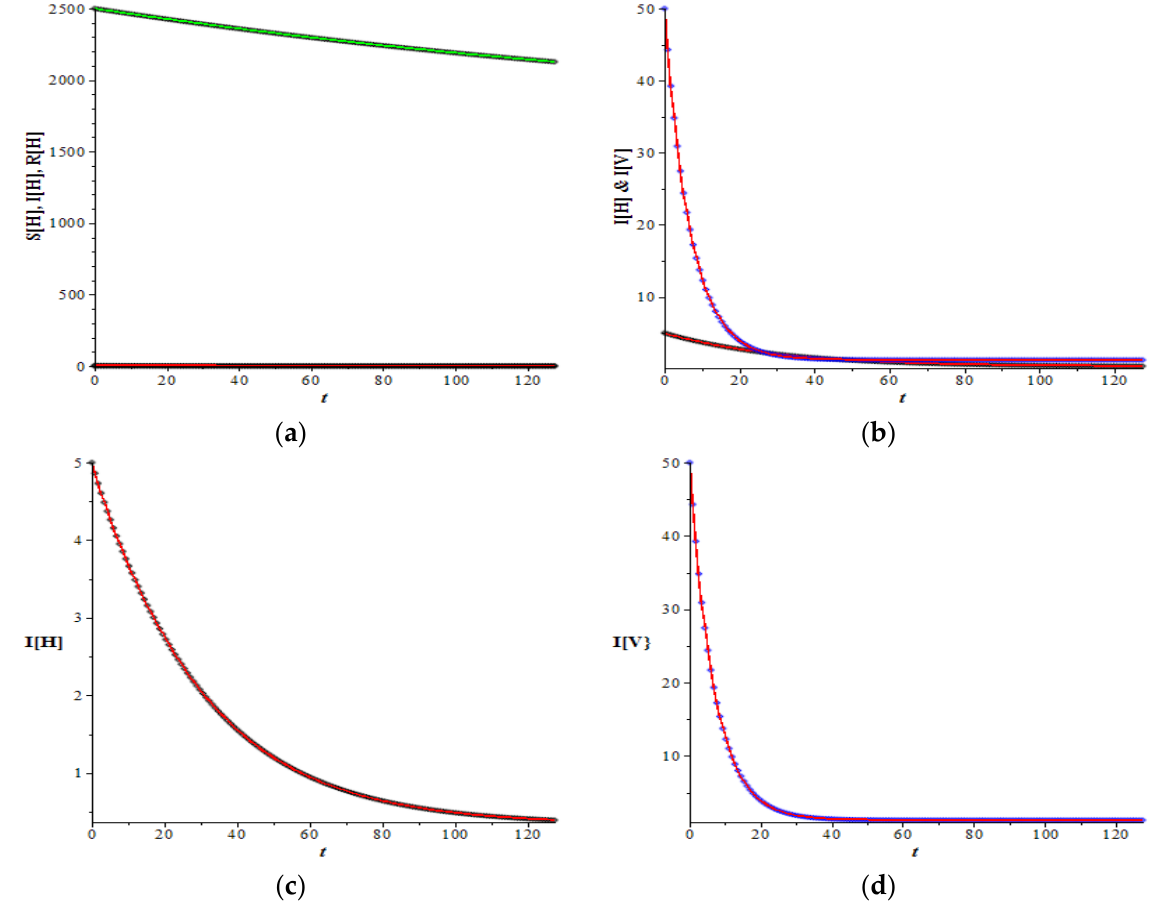
Figure 5. ( a ) shows the graphs of S H ( t ) , I H ( t ) , and R H ( t ) . To compare the number of infected humans and mosquitoes, we plot I H ( t ) in ( c ) and I V ( t ) in ( d ), while ( b ) plots them in one frame. Here, we use the data set which has a very small basic reproduction number, i.e., R 0 = 0.042.